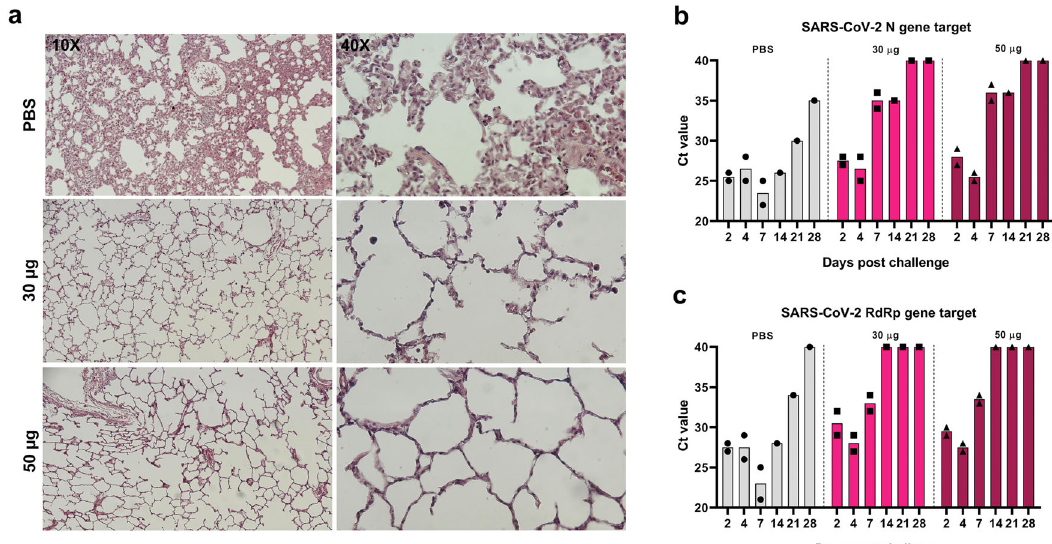
Fig. 6 Induction of proper protection against SARS-CoV-2 in rhesus macaques by COReNAPCIN ® . Rhesus macaques ( n = 2 each group) were immunized with PBS or COReNAPCIN ® (30 μ g or 50 μ g) at days 0 and 28 and challenged with 2 × 10 8 PFU SARS-CoV-2 on day 21 post boost. a Seven days post-challenge, lung tissues were harvested from one rhesus macaque per group and were sectioned for hematoxylin and eosin (H&E) staining and histopathology evaluation. The representative images of lung sections from PBS treated and both vaccination groups taken at 10X and 40X magni fi cation are shown. b , c Nasal swabs were collected at days 2, 4, 7, 14, 21, 28 post challenge, and assessed by qRT- PCR for detection of N ( b ) and RdRp ( c ) genes of SARS-CoV-2 as indicators of virus presence in the upper respiratory tract. In bar plots, each data point is shown and the height of each bar represents the